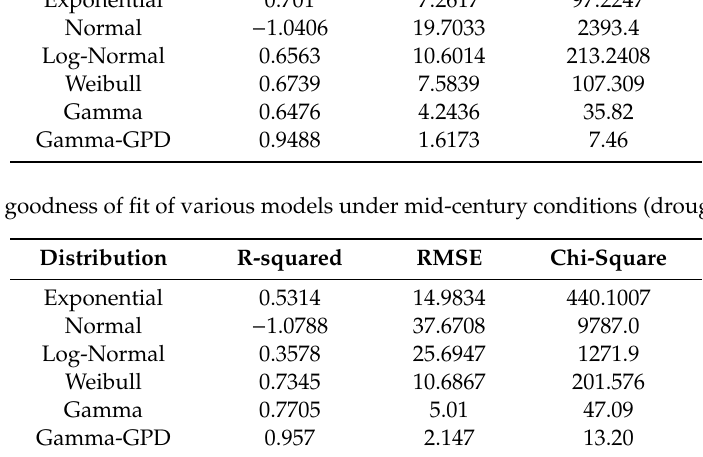
than zero (all drought events) are shown in Figure 9 left-panel. The GPD of drought durations is short-tailed ( (cid:2022) < 0) under the current condition but becomes heavy-tailed ((cid:2022) > 0) during the mid- century period, meaning that the duration of drought events will increase by the middle of century. The scale parameter of the Gamma distribution for drought duration is increasing, which means that the variability of drought durations will increase in the middle of century. Figure 9. ( left-panel ) Probability distribution functions of drought durations; and ( right-panel ) probability distribution functions of drought intensities.